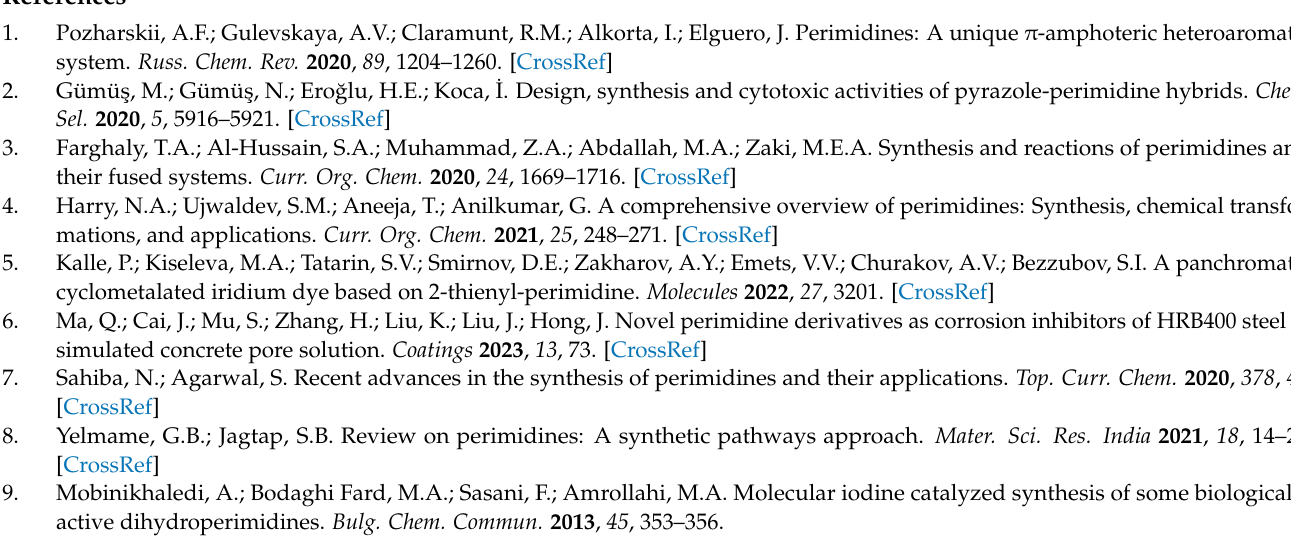
Figure S3: Partial 1H NMR spectrum of 2-(1H-imidazol-2-yl)-2,3-dihydro-1H-perimidine in DMSO- d6; Figure S4: NOESY spectrum of 2-(1H-imidazol-2-yl)-2,3-dihydro-1H-perimidine in DMSO-d 6 ; Figure S5: Partial NOESY spectrum of 2-(1H-imidazol-2-yl)-2,3-dihydro-1H-perimidine in DMSO- d 6 ; Figure S6: 13 C NMR spectrum of 2-(1H-imidazol-2-yl)-2,3-dihydro-1H-perimidine in DMSO-d 6 ; Figure S7: HSQC spectrum of 2-(1H-imidazol-2-yl)-2,3-dihydro-1H-perimidine in DMSO-d 6 ; Figure S8: HMBC spectrum of 2-(1H-imidazol-2-yl)-2,3-dihydro-1H-perimidine in DMSO-d 6 ; Figure S9: IR